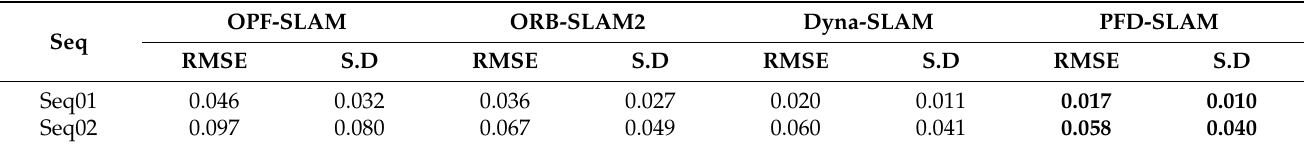
Table 6. Comparisons of RPE-RMSE (m/s) in translational drift in real scenes.